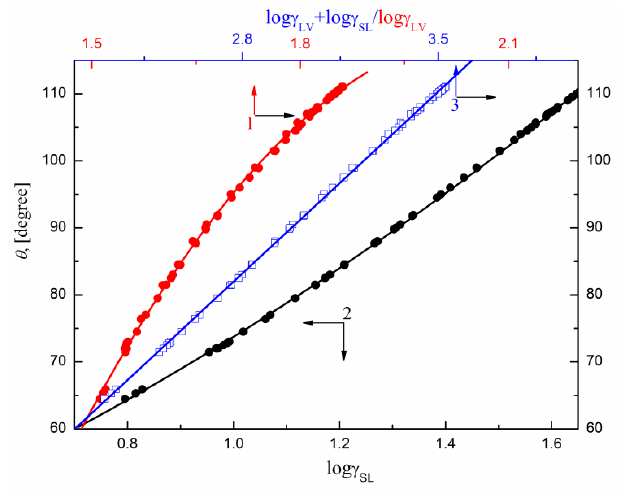
Figure 6. A plot of the contact angle ( θ ) of the aqueous solution of DDGP, DM, SMD and SML on the PTFE surface vs. the surface tension of solution ( γ LV ) (curve 1), PTFE–solution interface tension ( γ SL ) (curve 2) and (curve 3).